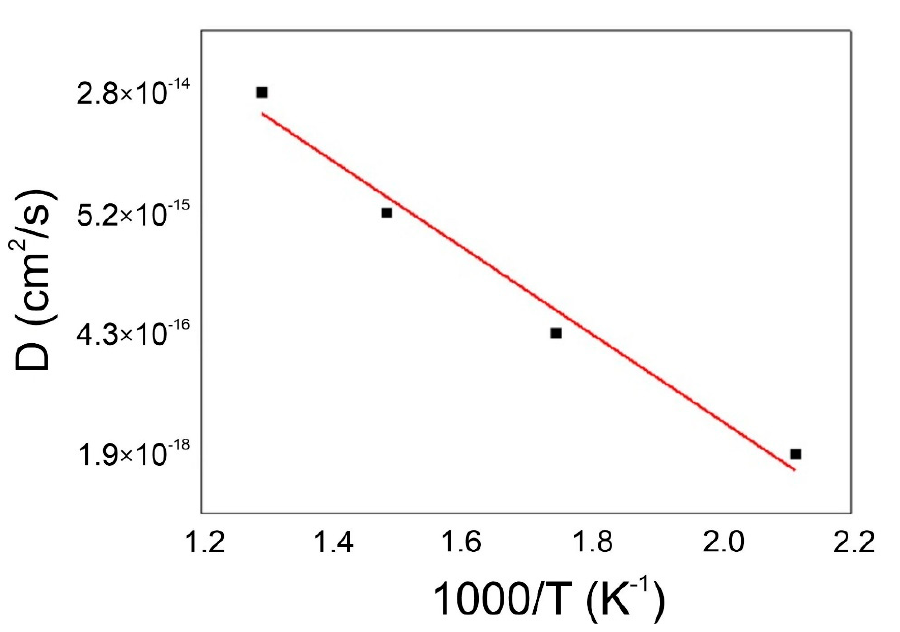
Figure 9. Arrhenius plot for D c of CuNi2Si.